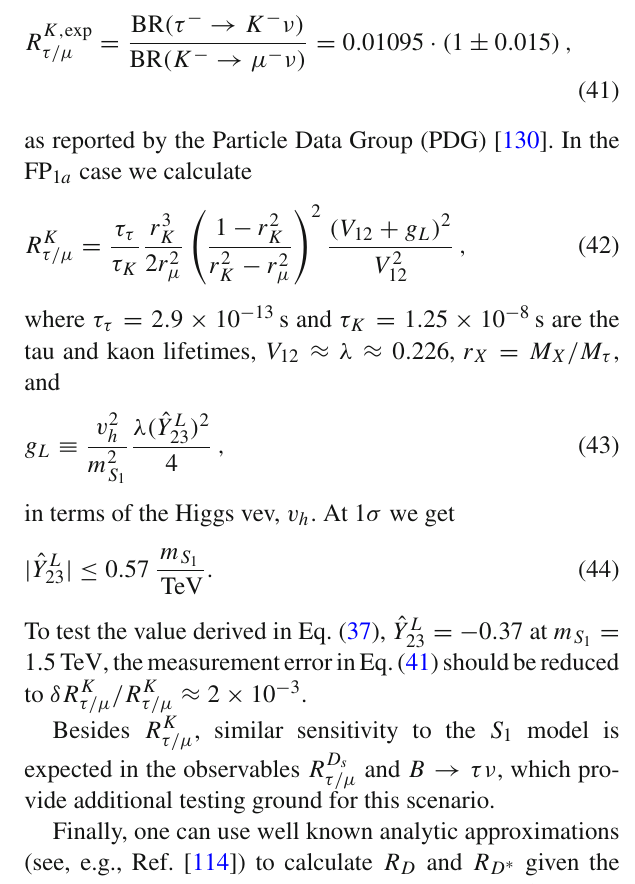
(cid:6) Y L Y R , ˆ Y L ) of the 33 23 33 23